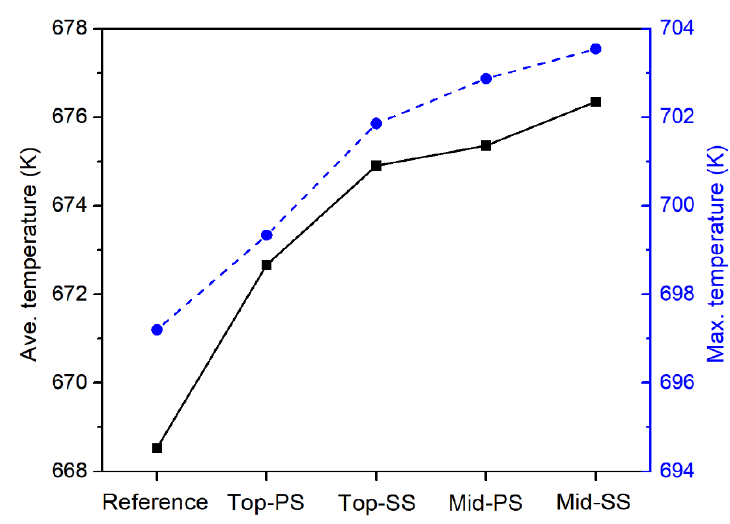
Figure 14. Average and maximum temperature of the S 2 vane surface under various blade conditions.